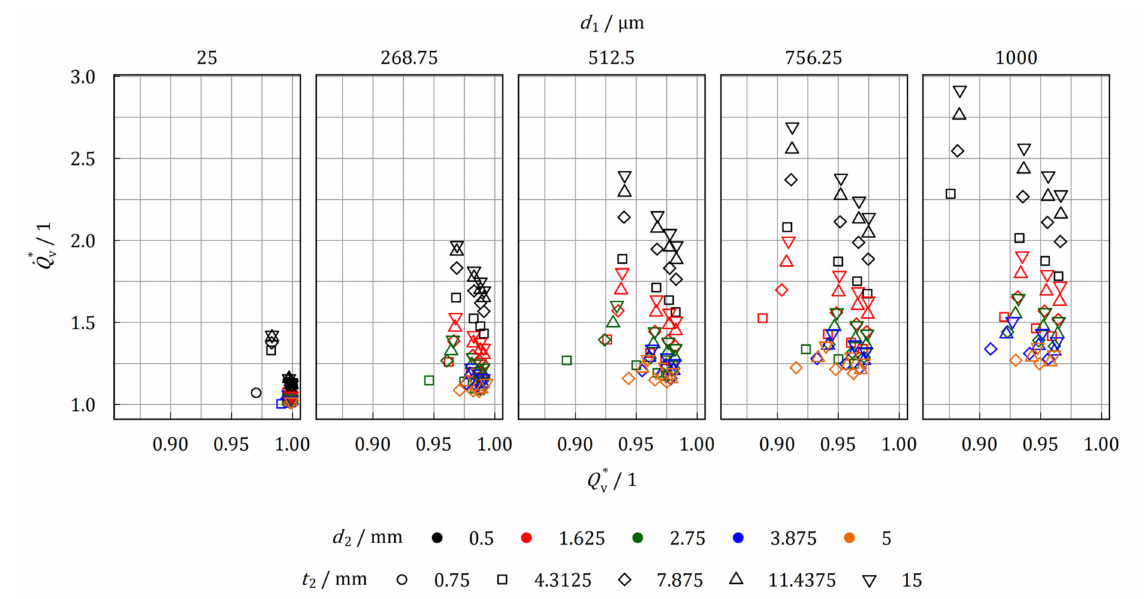
Figure 20. Ratio of mean volume specific power vs. ratio of volume specific storage capacity for all variations of the wire cloth heat exchanger in dependency of wire diameter d 1 , tube diameter d 2 and the tube distance t 2 for stainless steel as material.